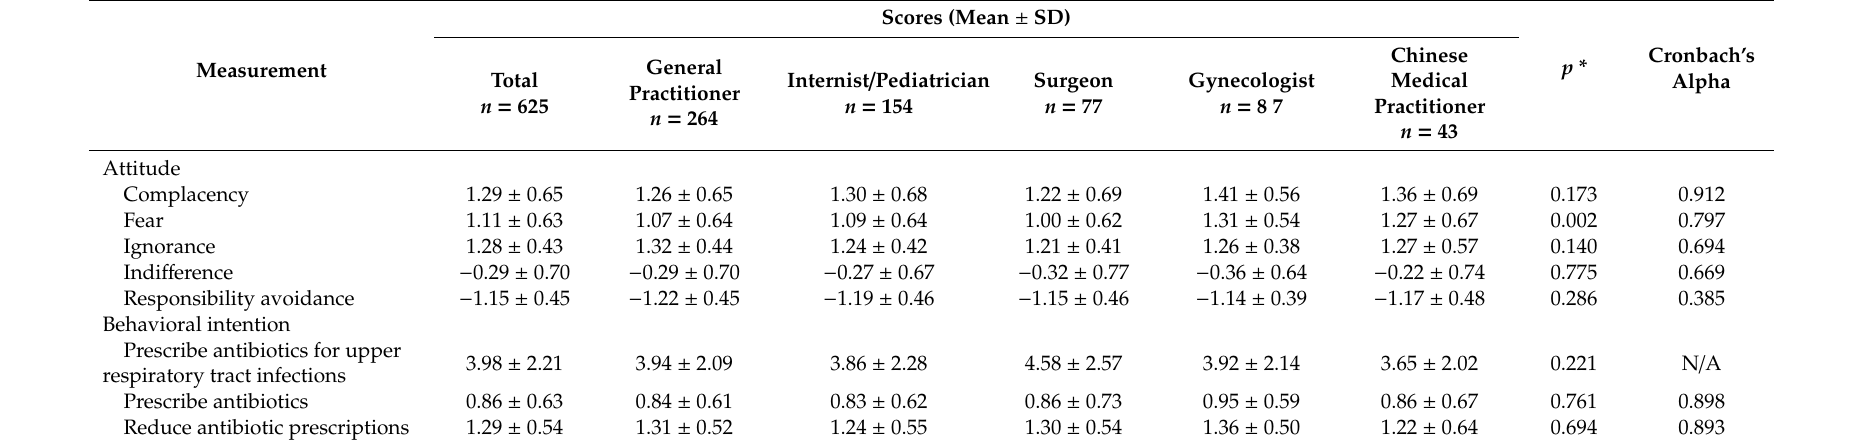
Table 3. Attitudes and behavioral intentions of respondents toward antibiotic